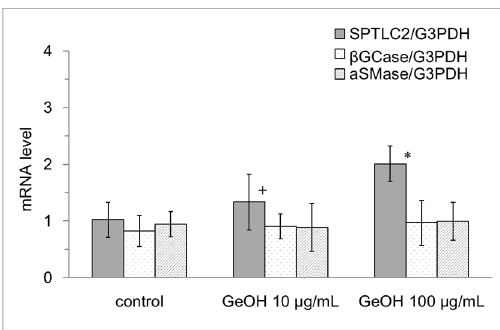
Figure 7. Effects of GeOH on ceramide synthesis gene mRNA expression in the epidermis model. Epidermis models were cultured for 3 days in medium supplemented with 10 or 100 μ g/mL GeOH. Total RNA was isolated from the cells, and quantitative reverse transcription-polymerase chain reaction was performed using six samples. The results are shown relative to the control. * p < 0.05 vs. control, + p < 0.1 vs. control.